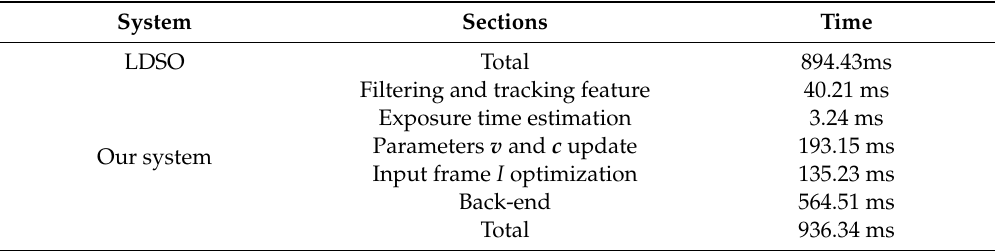
Table 2. Timing results of our system and